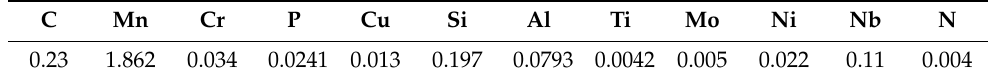
Table 2. Nb-MA steel composition in